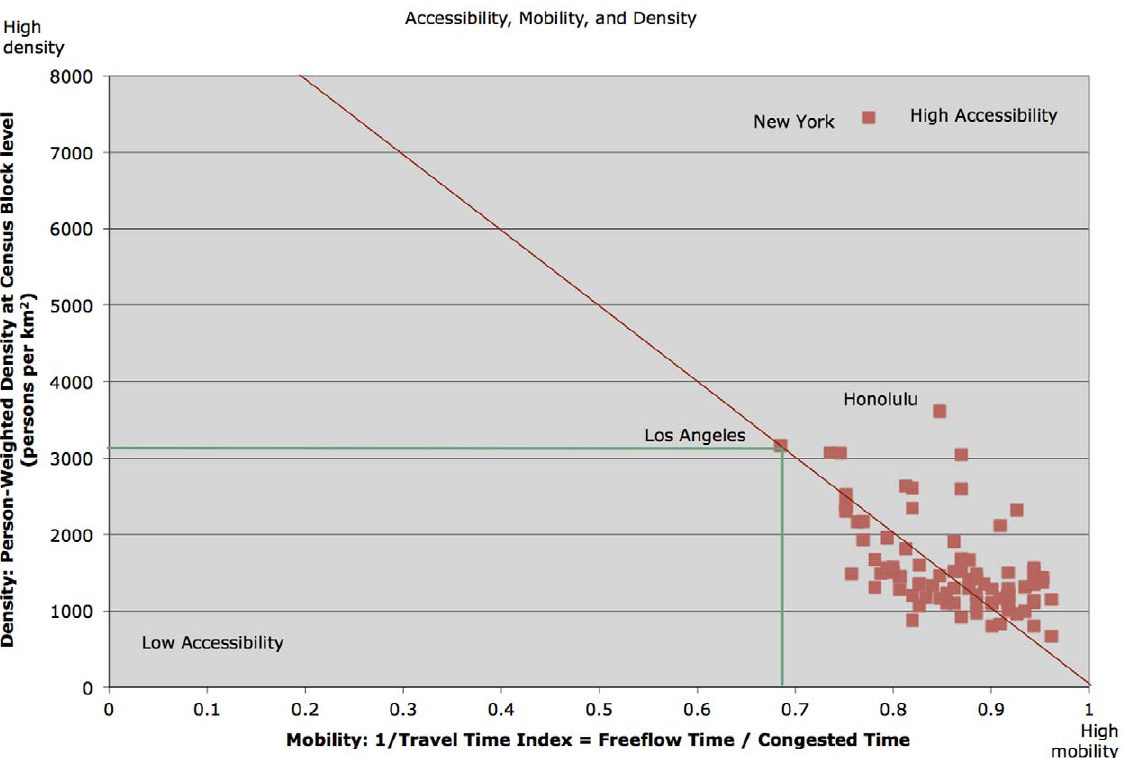
Figure 1. Mobility vs. Density.